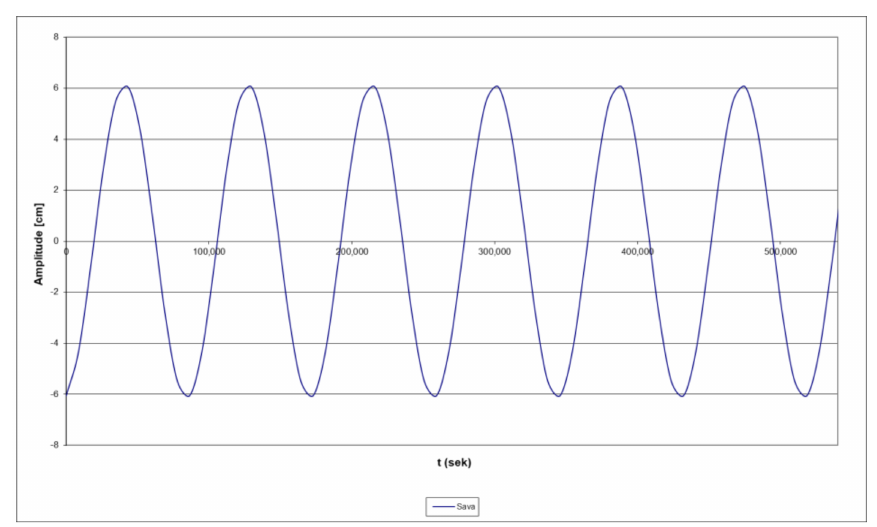
Figure 9. Synthetic record of the Sava oscillation with the period 24.5